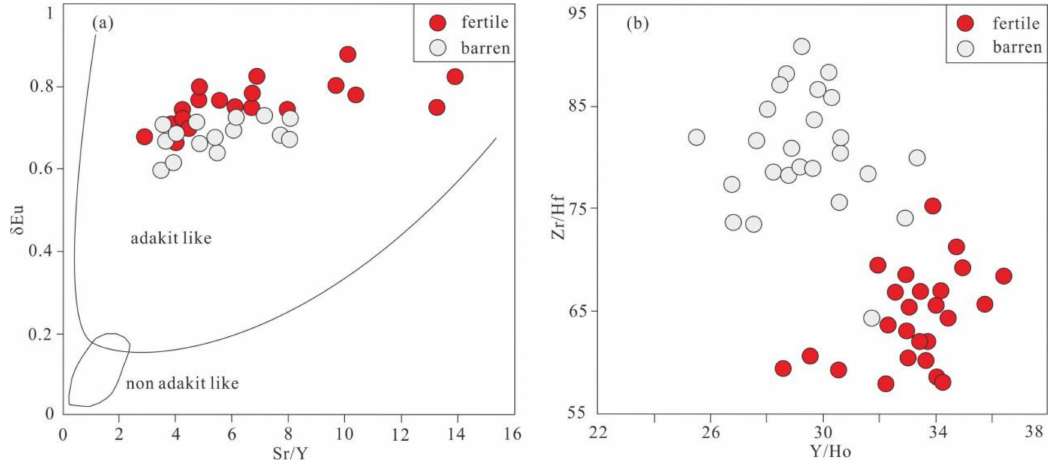
Figure 9. ( a ) Plot of δ Eu vs. Sr/Y in apatite [7]; ( b ) Plots of Y/Ho vs. Zr/Hf in zircon